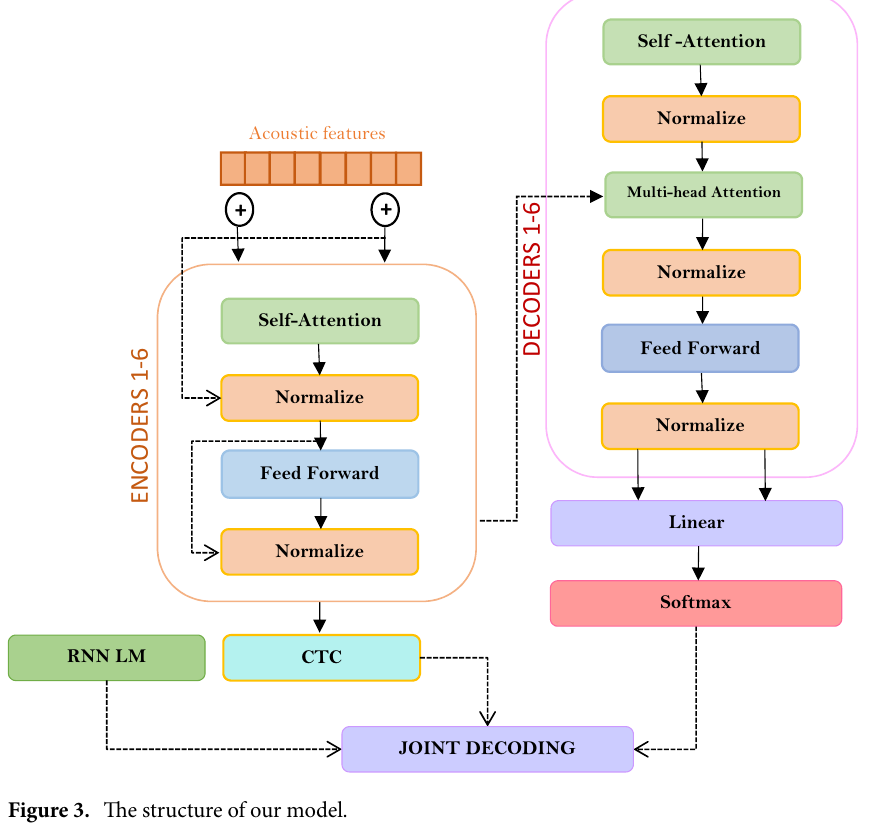
Figure 3. The structure of our